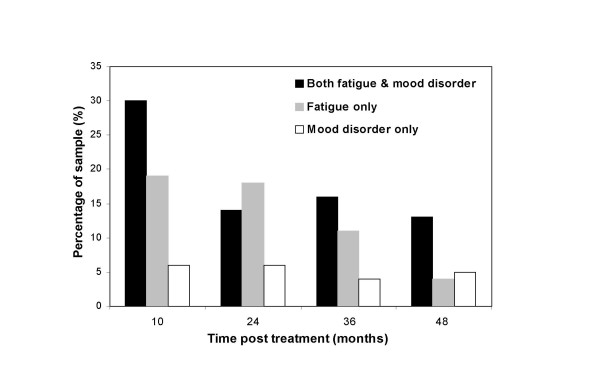
Longitudinal prevalence of fatigue and mood disorder in women followed after adjuvant treatment for early stage breast cancer (n = 176). Although the number of respondents decreased at 24, 36, and 48 months, the denominator was kept constant for these estimates.